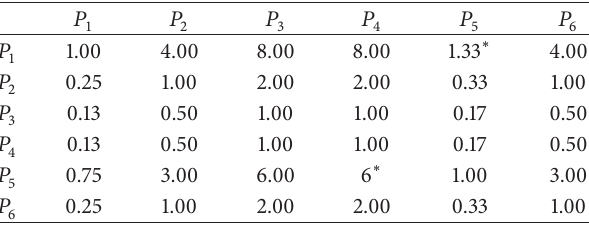
Table 11: Solution matrix of alternatives by Yu’s approach (Example